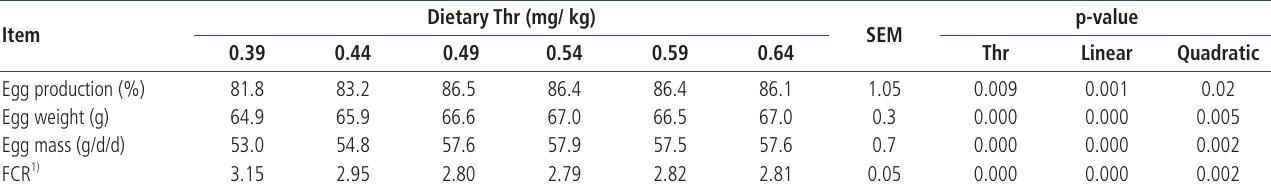
Table 2. Effects of dietary threonine (Thr) supplementation on the performance of laying ducks